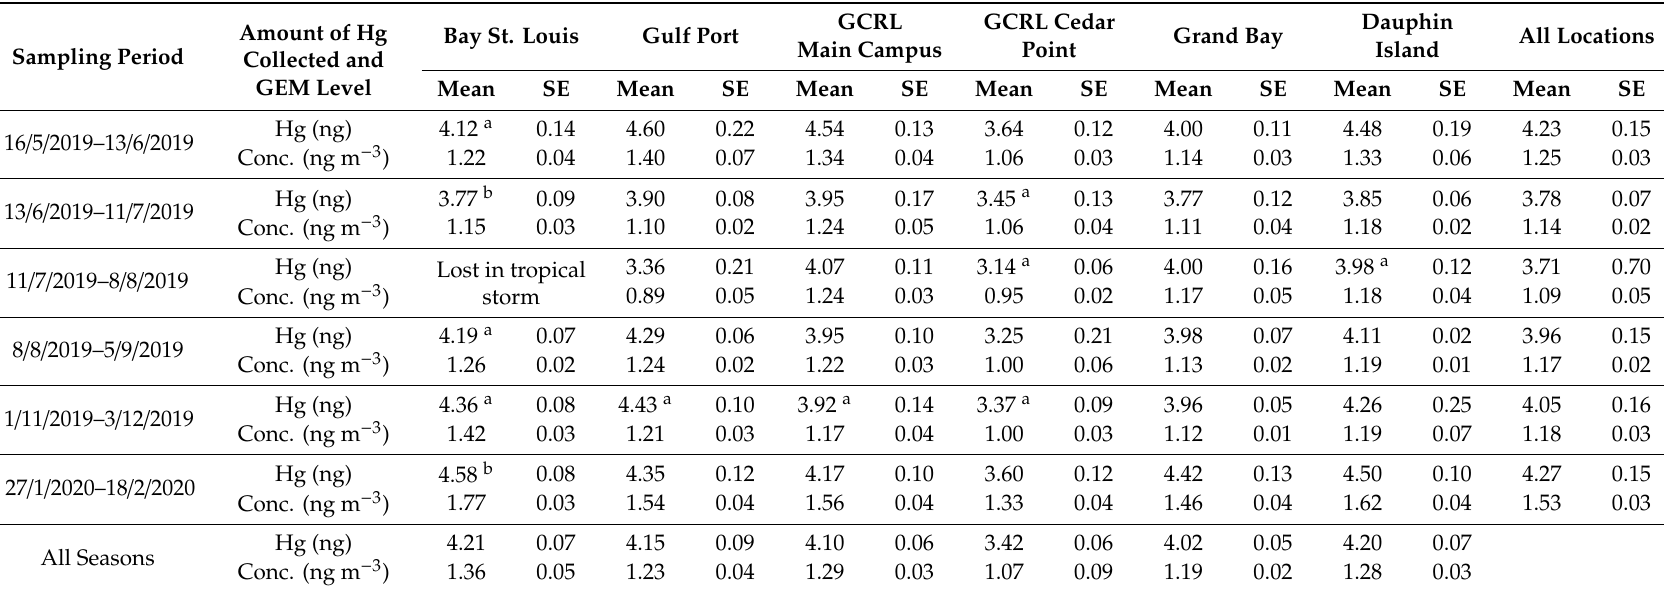
Table A2. Amount of Hg (ng) collected on each PAS and GEM concentrations based on those amounts ( n = 6, unless otherwise